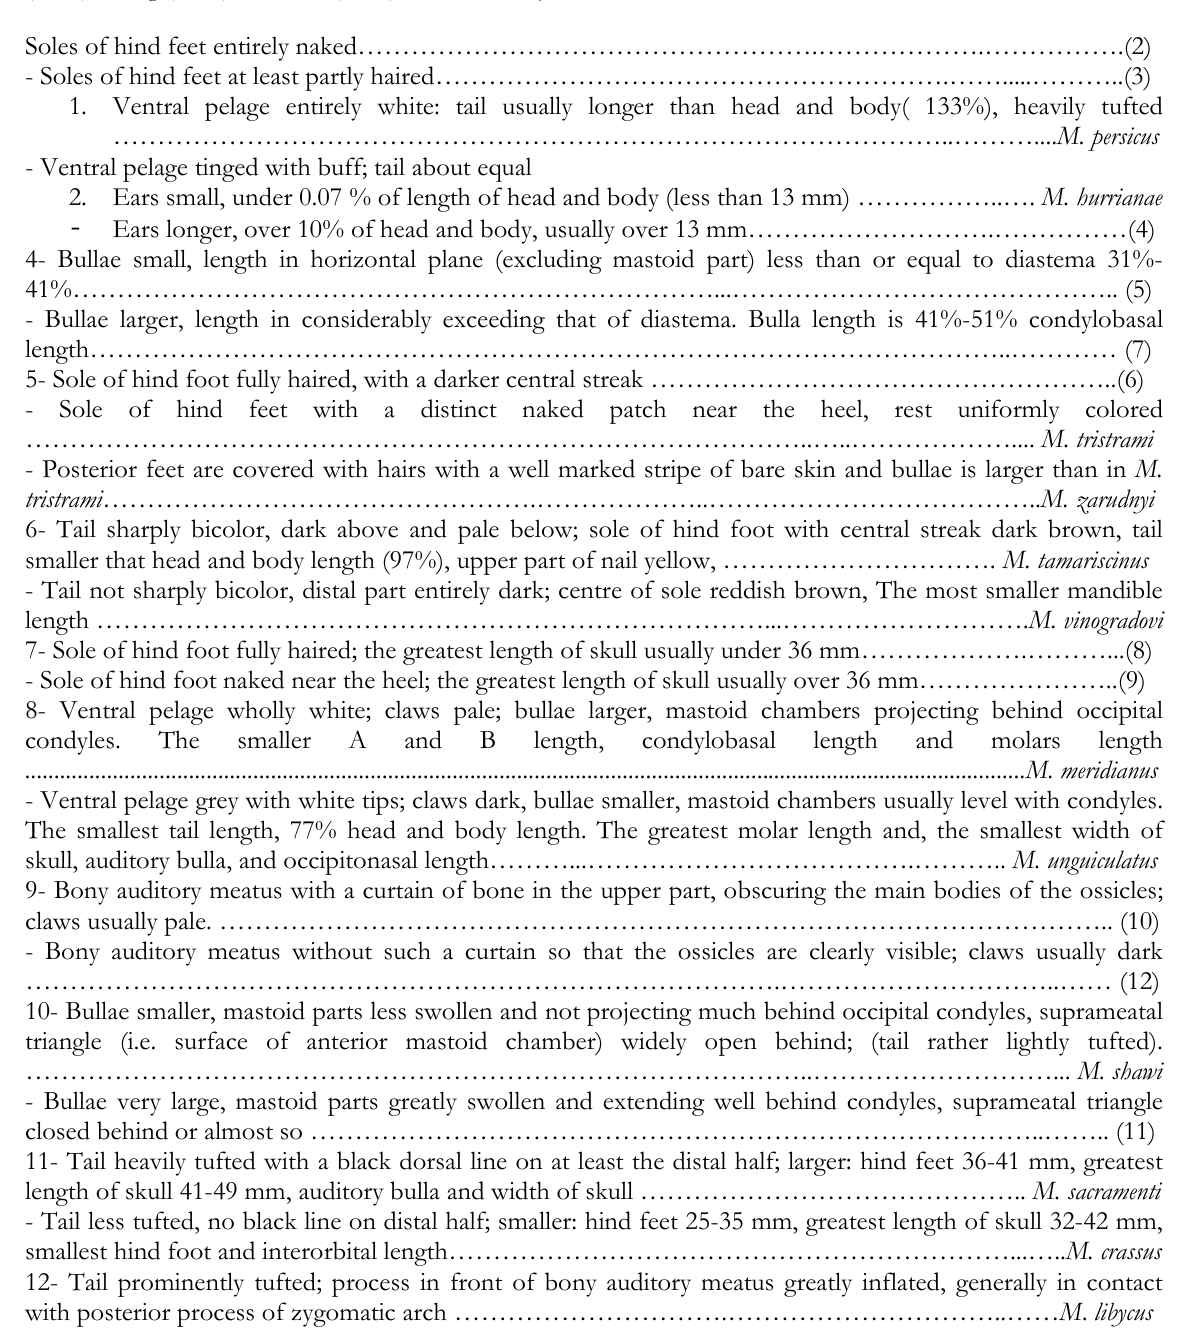
A PPENDIX 2- Identification key of morphospecies of Meriones Corbet (1978), Petter (1957 and 1959), Corbet (1978), Tong (1989), Darvish (2009) and this study.